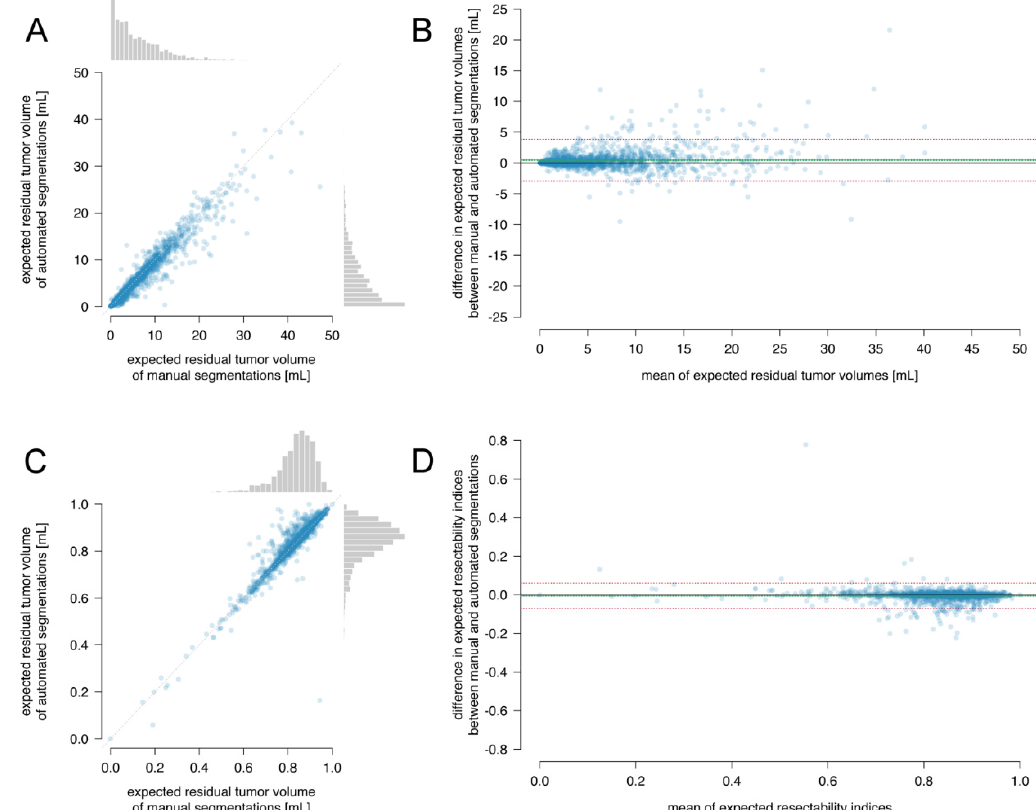
structure indicated in grey. The width of a bar corresponds with the relative volume of a structure. ( C ) Correlation plot between the number of patients with structure involvement between the manual and automated segmentations. The dot- ted diagonal indicates the identity line.